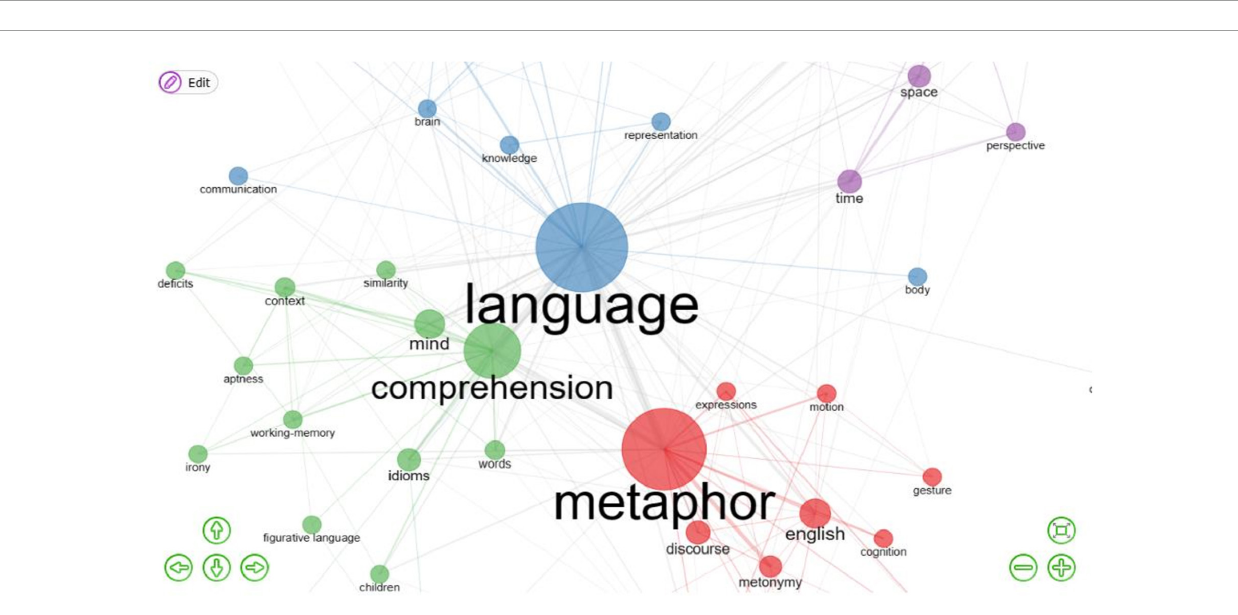
FIGURE12 Co-occurrence of keywords plus. The four distinct clusters are blue, green, red, and